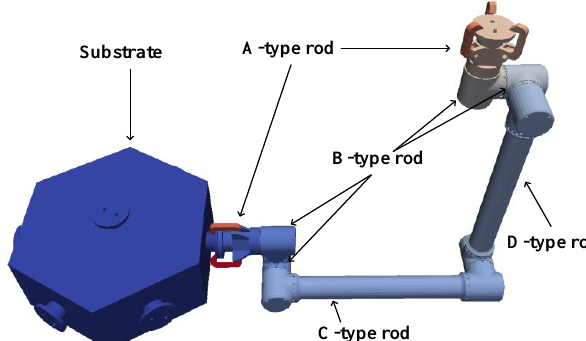
Figure 2. Mechanic arm configuration mechanism diagram. Table 1. Space dobby robot parameters.